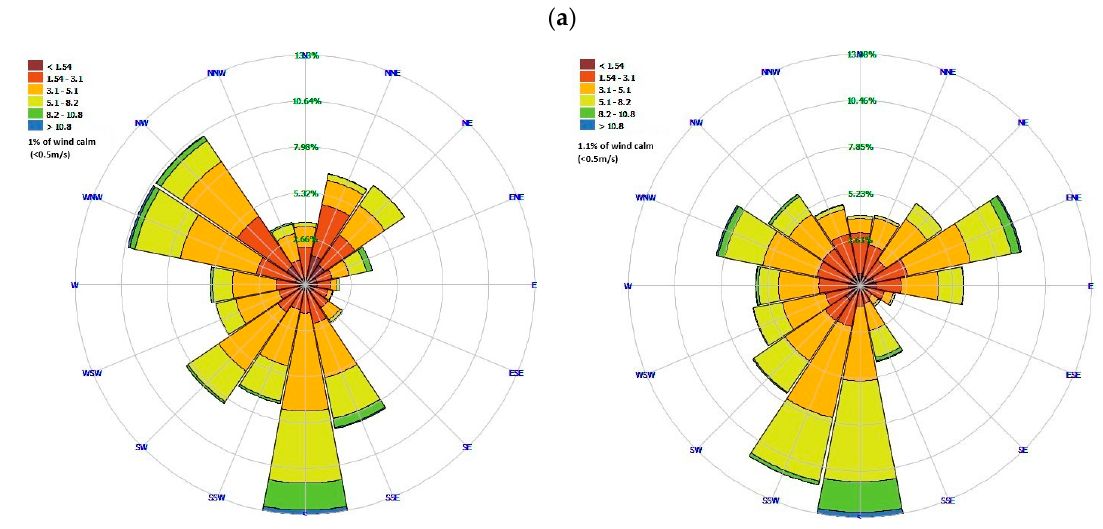
Figure 9. Monthly mean wind speeds determined by the WRF/CALMET model in selected towns in 2018 (source: own study). On the other hand, the classification of wind speeds for selected grids from the studied area shows that the most frequently occurring were the winds with speeds in the 3–5 m/s range (30.5– 38.1%), referred to as mild winds (Figure 10). Weak winds, i.e., 1.5–3 m/s, and winds with speeds